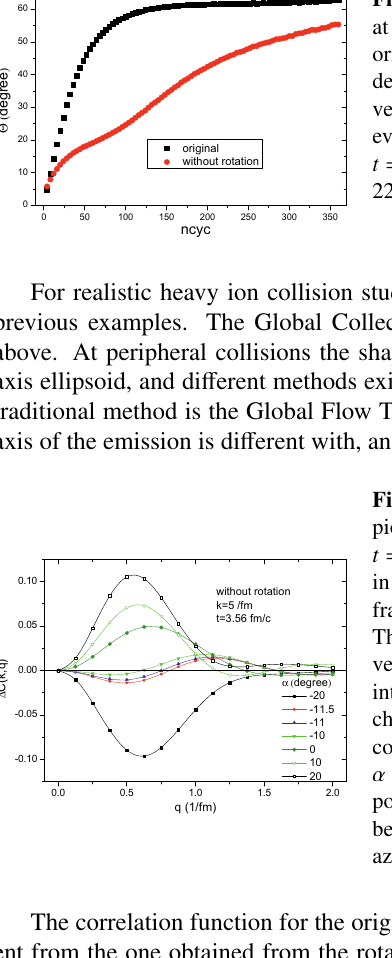
Figure 7. The change of the flow angle with time in a Pb + Pb reaction √ s = 2 . 76TeV and b = 0 . 7 b at NN max , for the flow tensor for the original flow evolution (black points), while the flow angle development of the flow tensor where the rotational component of the velocity was removed is also shown (red dots). The DCF was evaluated and presented at the time-step, nc y c = 84 (corresponding to t = 3 . 56fm / c), where the flow angle of the rotation-less flow tensor is 22.2 degrees.